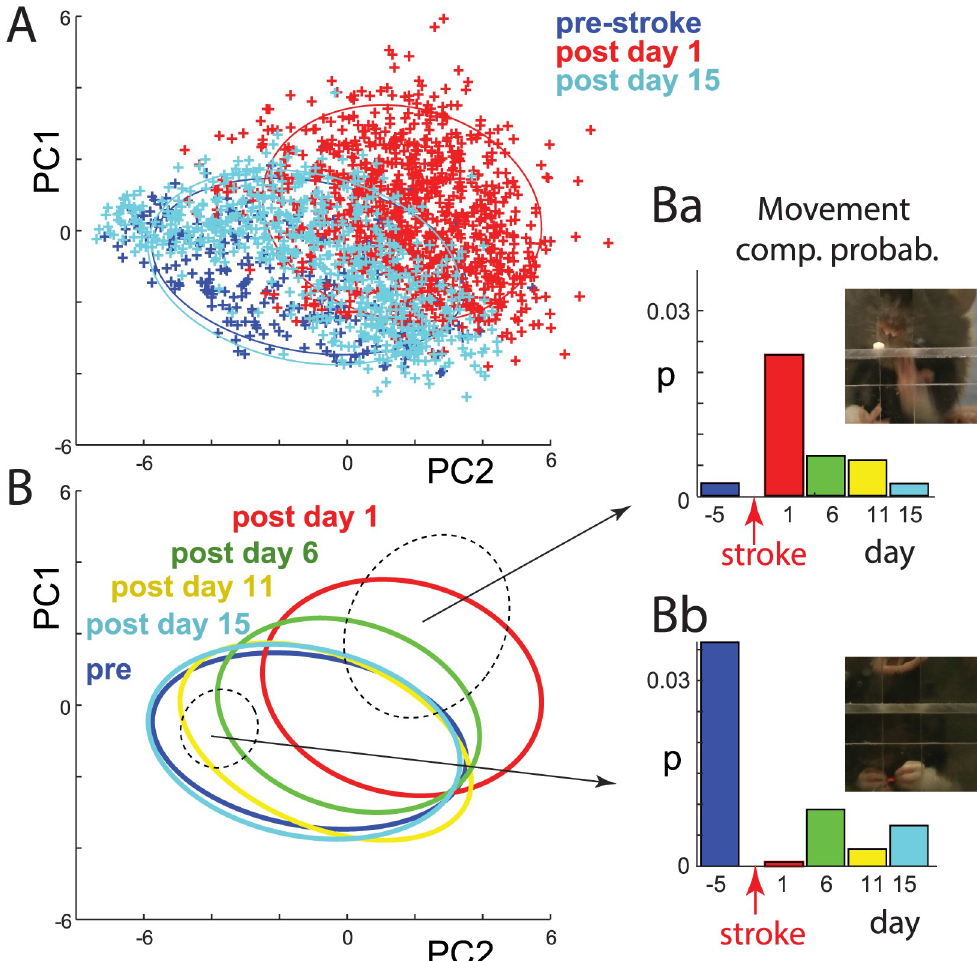
Fig 6. Quantifying changes in individual movement components during stroke recovery using the internal network representation. (A) Representation of video frames in the internal feature space of the network, as in Fig 4A, but with added points from day 15 after stroke (light blue). Note that points on day 15 shift toward prestroke (dark blue) values, indicating movement recovery. (B) Ellipses outlining the distribution of points before stroke and for all filming days after stroke. Note the gradual shift of the poststroke distributions toward prestroke space. Dashed ellipses illustrate sample subclusters representing single movement components. (Ba and Bb) Probability of points falling within a given subcluster across days. For example, the high red bar in Ba shows that this movement component was mostly present on day 1 poststroke. The sample network and data on which this figure is based are available at github.com/hardeepsryait/ behaviour_net. Movement comp. prob., movement component probability; PC, principal